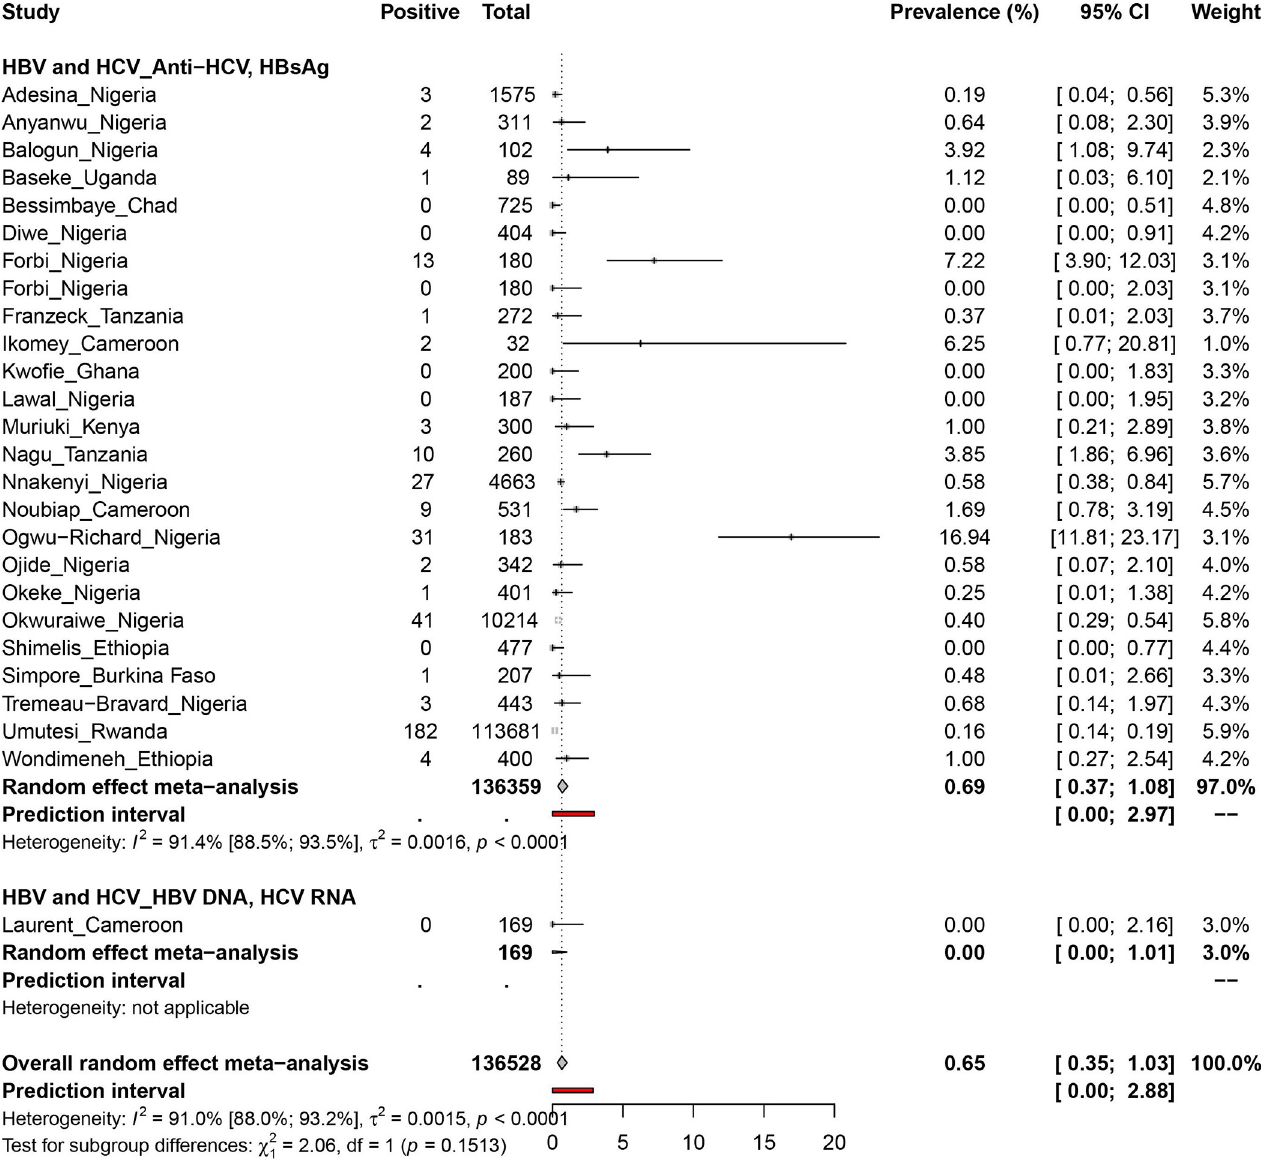
Fig 6. Prevalence estimate of hepatitis B and C virus coinfection in PLHIV in